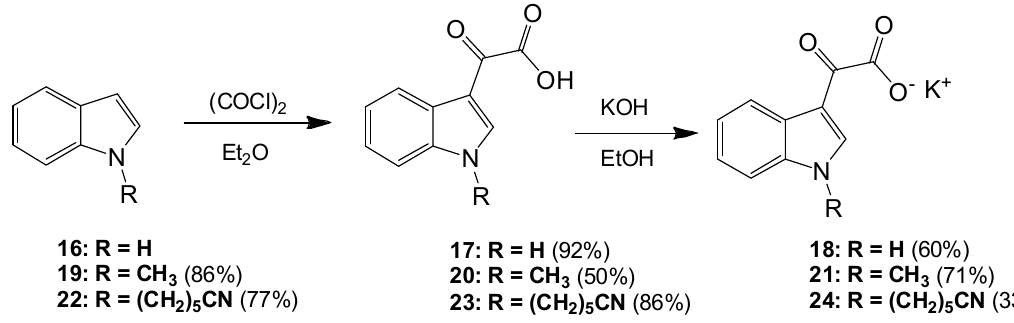
Scheme 1. Synthesis of indole potassium glyoxalate salts 18 , 21 and 24 .